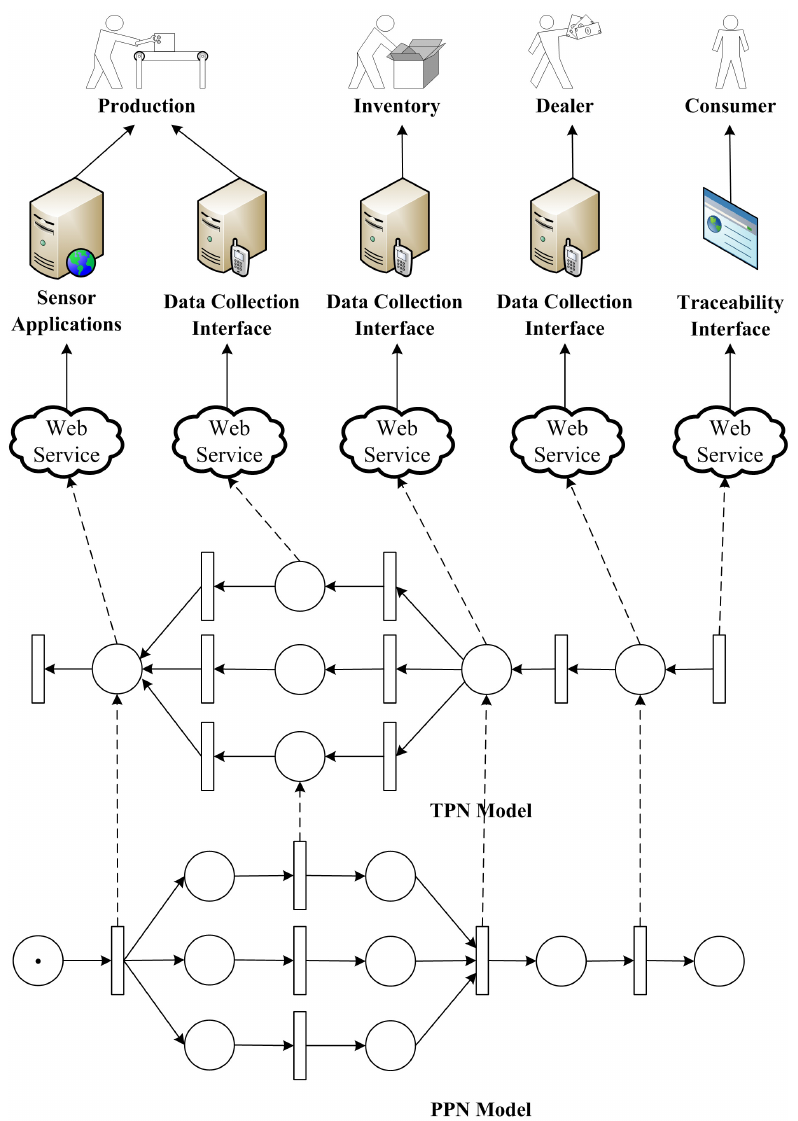
Figure 8. Framework of a traceability solution for cyber-physical manufacturing